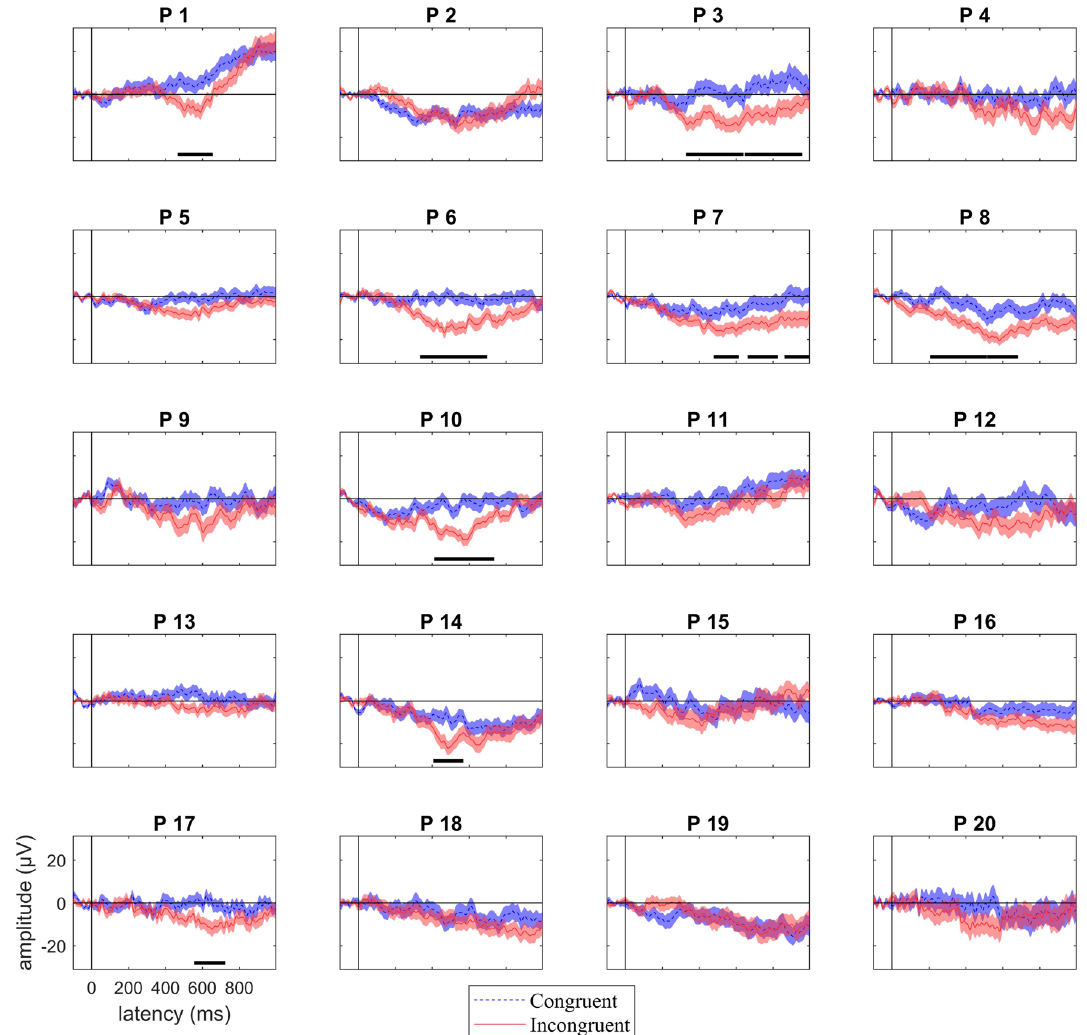
Figure 6. Individual participant responses to target words following congruent (dashed blue) and incongruent (solid red) sentences in our region of interest. Shading indicates standard error of the mean. Time points where there was a statistically significant N400 effect are indicated with a solid, horizontal, black line. P indicates participant, with participant numbering as in Fig. 2. 45% (8/20) of participants showed a statistical univariate N400